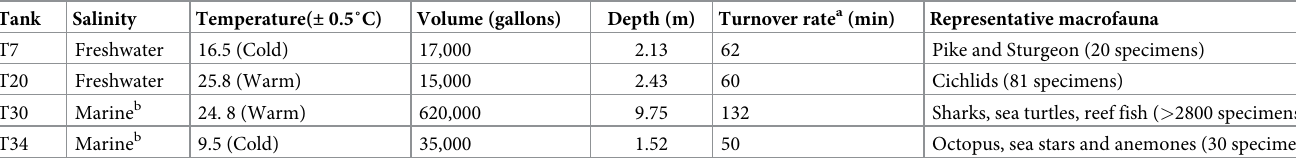
Table 1. Characteristics of Tennessee Aquarium study exhibits. Tank Temperature( ±